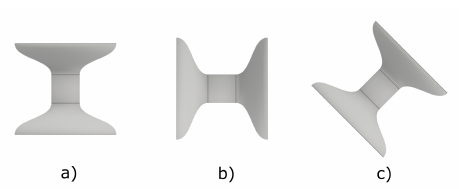
Figure 3. Orientation of the specimens durig produc- tion: a) vertical, b) horizontal and c) tilted.